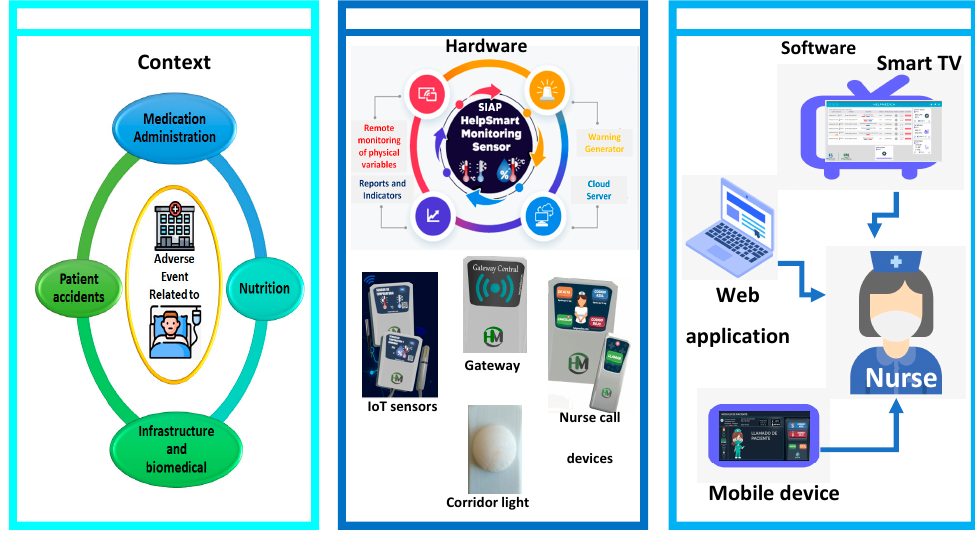
Figure 2. Graphical abstract.